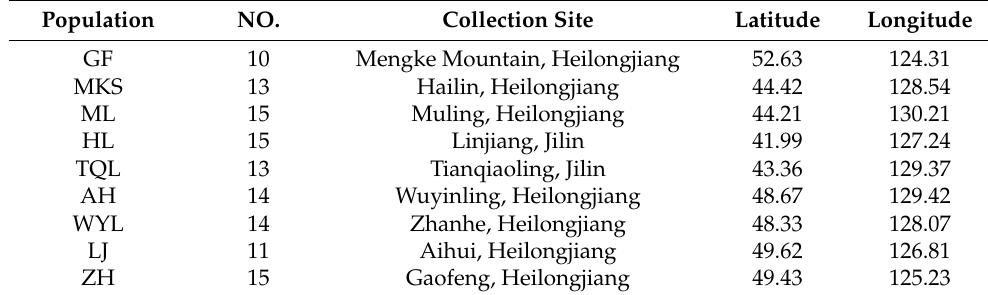
Table 2. Locations of 9 P. koraiensis